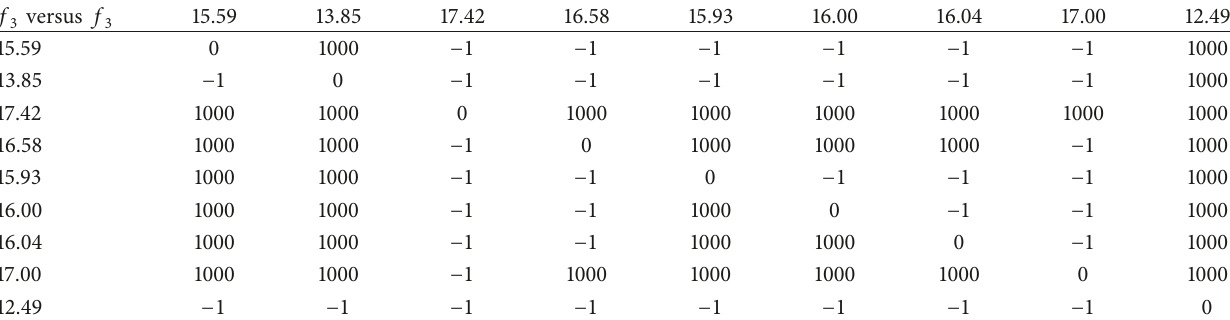
Table 7: Matrix A